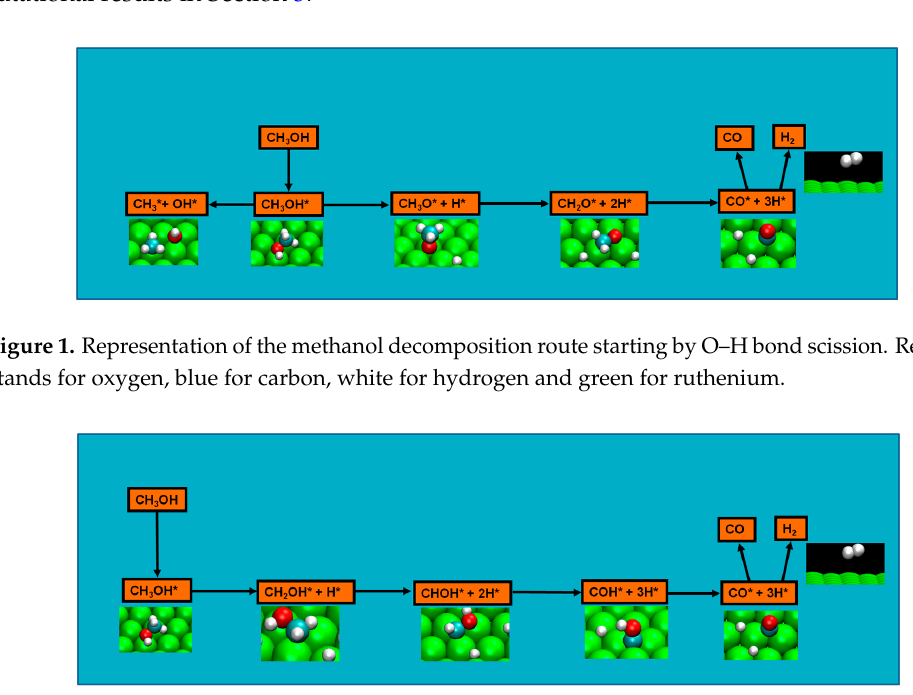
Figure 2. Representation of the methanol decomposition route starting by C–H bond scission. Red color stands for oxygen, blue for carbon, white for hydrogen and green for ruthenium.